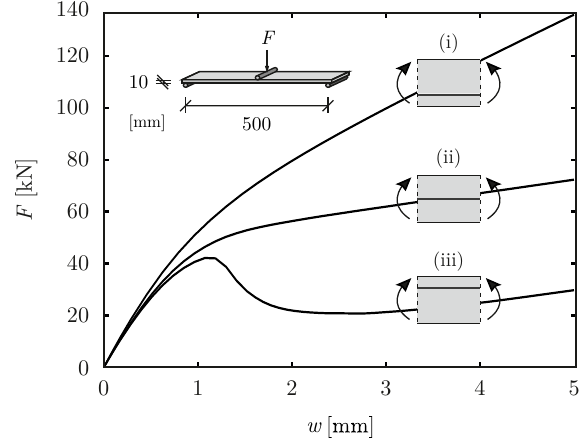
Figure 14. Load displacement curves of the simulation of carbon concrete beam with variation of the reinforcement position in the cross section subjected to bending